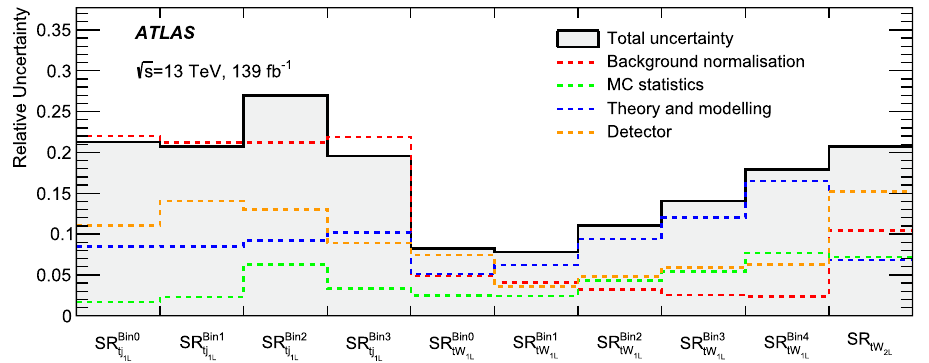
Fig. 8 Relative uncertainties in the total background yield in each SR for the three analysis channels, including the contribution from the different sources of uncertainty. The ‘Detector’ category contains all detector-related systematic uncertainties and is dominated by the jet energy scale and resolution. The ‘Background normalisation’ repre-